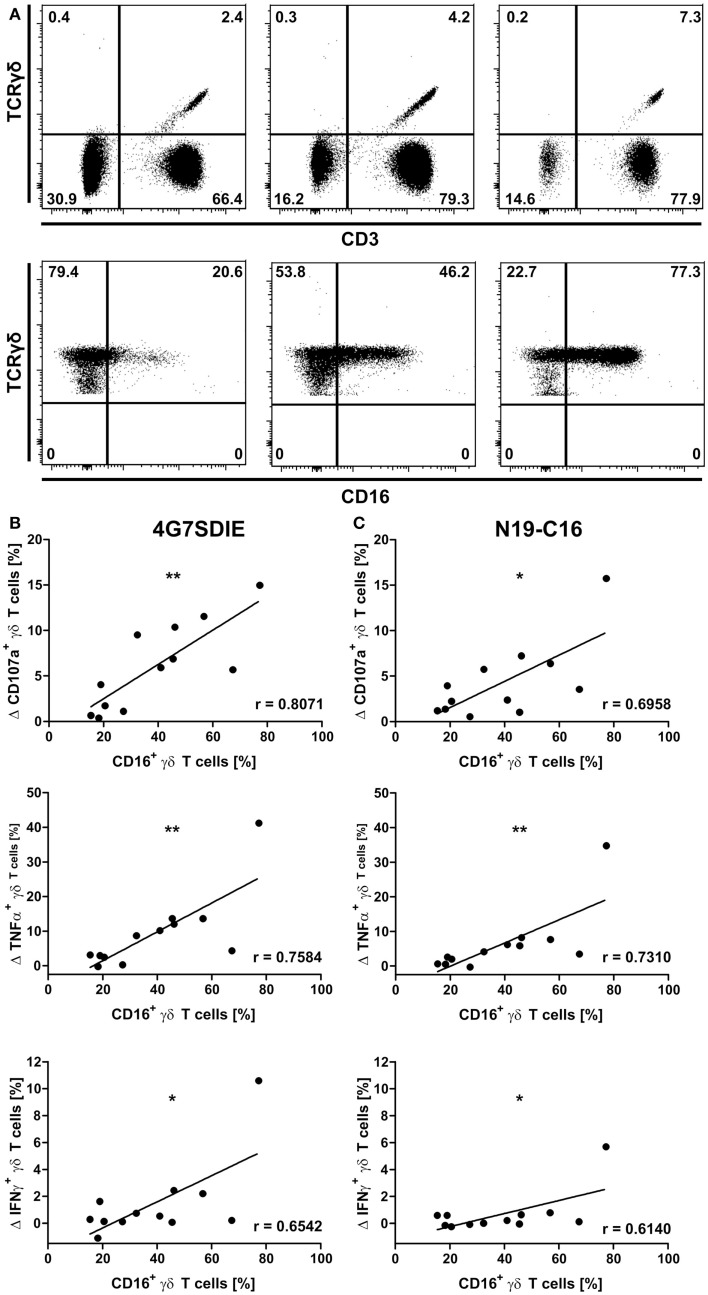
Correlation of CD16-expression by γδ T cells and degranulation and cytokine production of antibody-stimulated primary γδ T cells. CD16-expression of γδ T cells was assessed by flow cytometric analyses prior to functional assays. Gating hierarchy was: lymphocytes, single cells, viable cells, CD3+TCRγδ+, TCRγδ+CD16+. Gates were defined based on marker-negative populations within the viable cells. Three representative donors are shown. Same gating strategy was used for all samples (A). PBMC were incubated with equal cell numbers of target cell lines NALM-6 and antibodies for 16 h. γδ T cell degranulation (CD107a) and cytokine production (TNFα and IFNγ) were detected on viable, single CD3+TCRγδ+ lymphocytes by extracellular and intracellular staining and flow cytometric analysis. Expression of CD107a, TNFα, and IFNγ induced by NALM-6 only was deducted from expression levels reached by incubation with NALM-6 and 4G7SDIE or N19-C16. PBMC were incubated with target cell line NALM-6 and medium, 1 μg/ml 4G7SDIE (B) and 1 μg/ml N19-C16 (C), respectively. Statistical significance was assessed using Pearson’s correlation. Experiments were performed in triplicates.